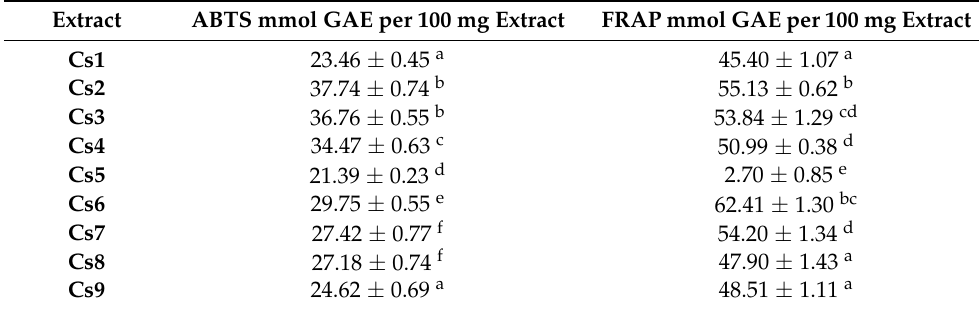
Table 3. Polyphenolic and iridoid constituents detected in C. spicatum extracts. Letters above the bars denote significant differences according to Fisher’s LSD test at p ≤ 0.05. Samples denoted by the same letter are not significantly